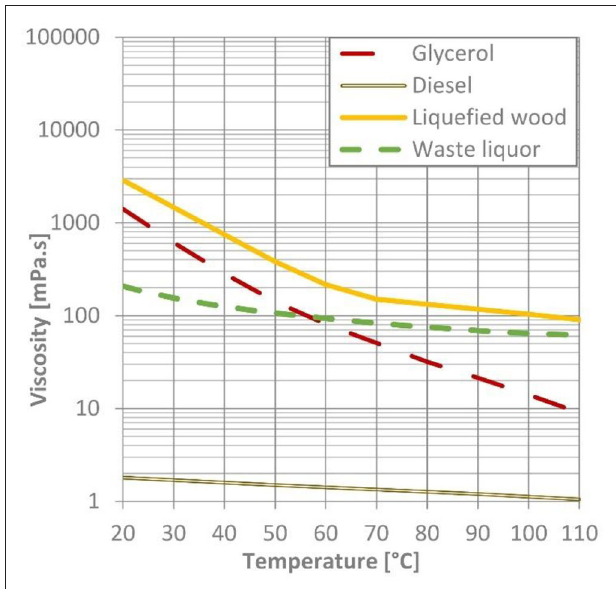
FIGURE 3 | Viscosity dependence on temperature for the investigated fuels.